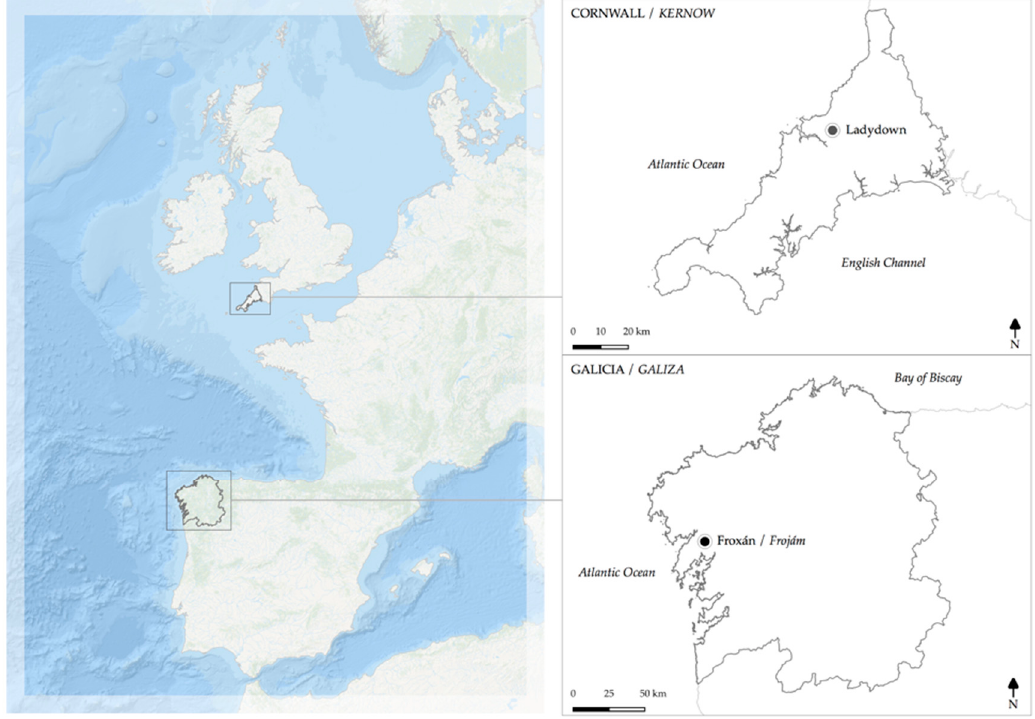
Figure 1. Location of the case ‐ study areas.